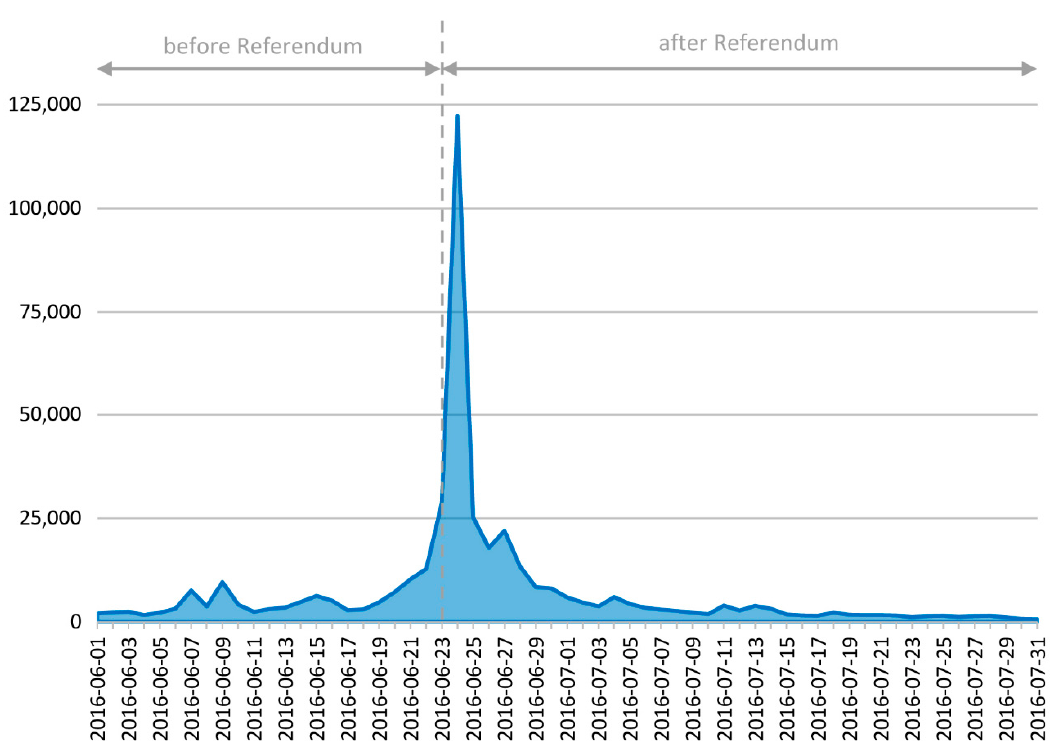
Figure 2. Daily amount of reactions (tweets) within the used dataset.